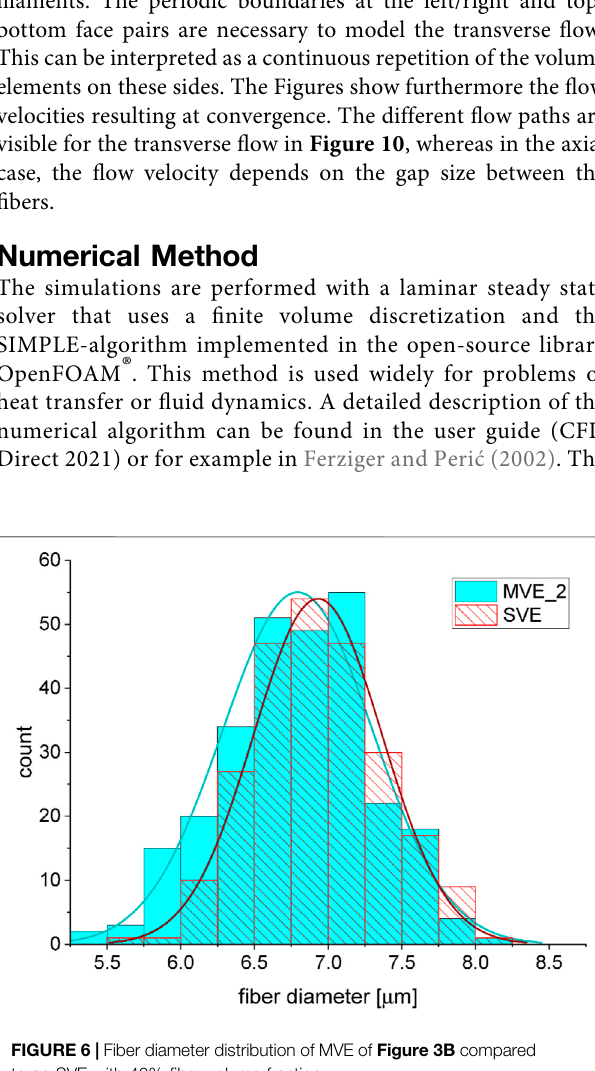
Frontiers in Materials |